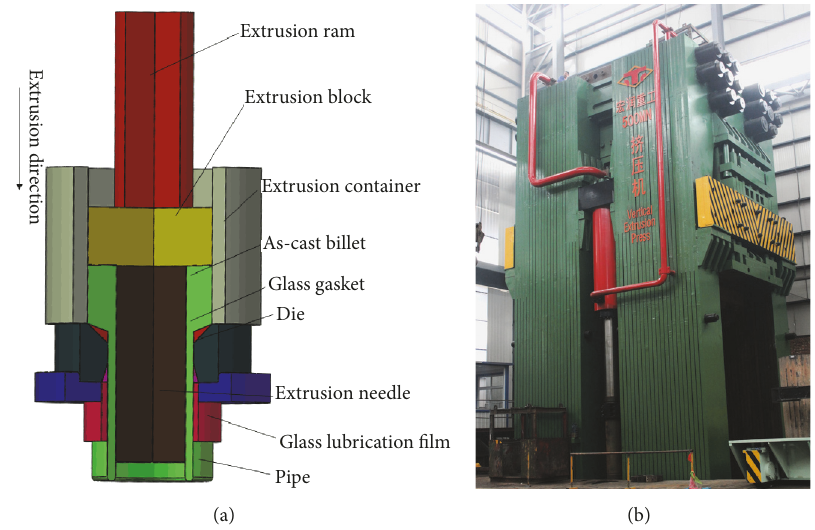
Figure 15: The structural diagram (a); 500 MN vertical hot extrusion machine (b).